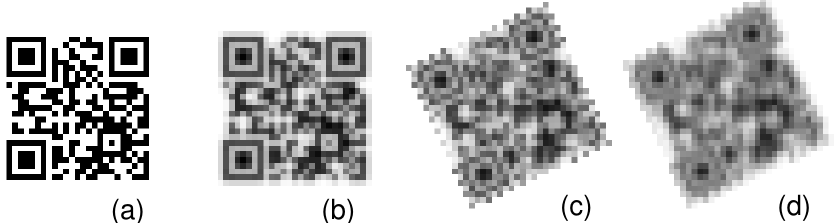
Figure 8. Example of MTF-based simulation of distortions during acquisition of QR code at Nyquist limit: ( a ) perfect ‘hard pixel’, ( b ) blurring due to Gaussian low-pass, plus blurring due subpixel misregistration because of: ( c ) rotation, ( d ) plus subpixel